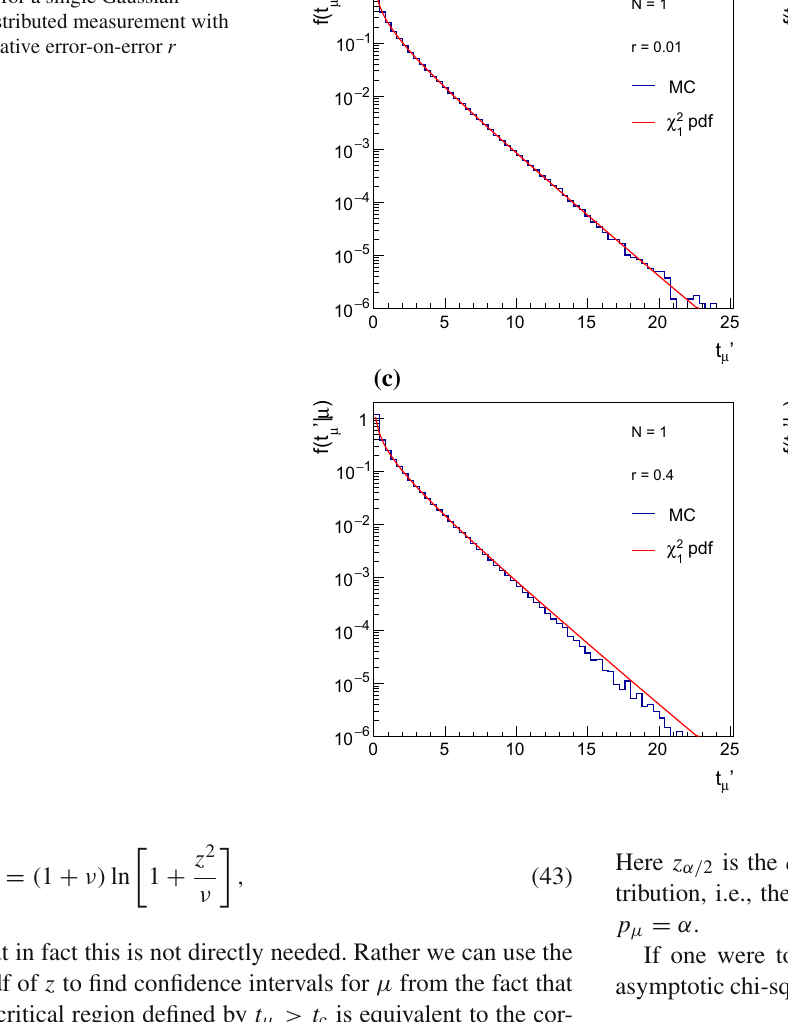
Fig. 3 Distributions of the Bartlett-corrected test variable t (cid:6) μ for a single Gaussian distributed measurement with relative error-on-error